Question: Which visualization type does this figure use?
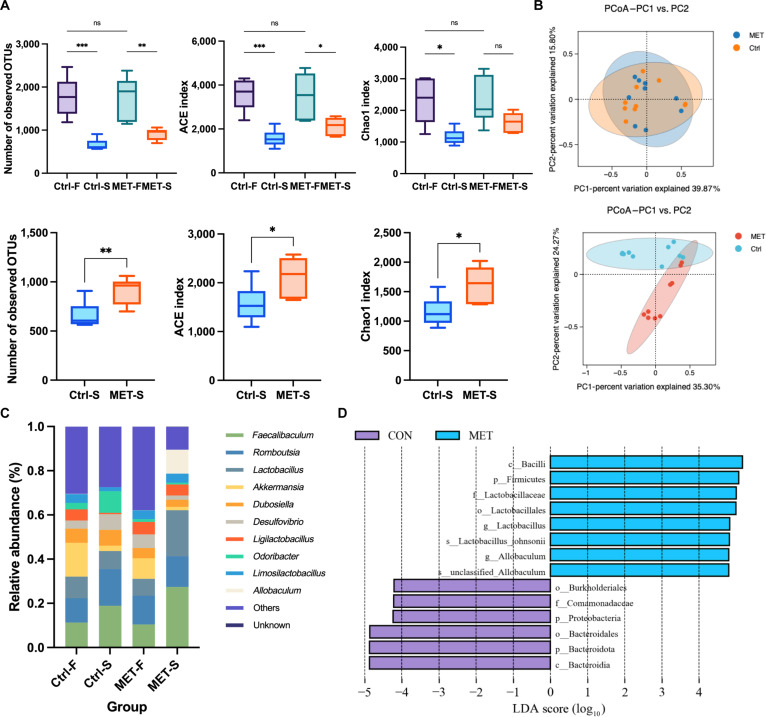
Answer: histogram